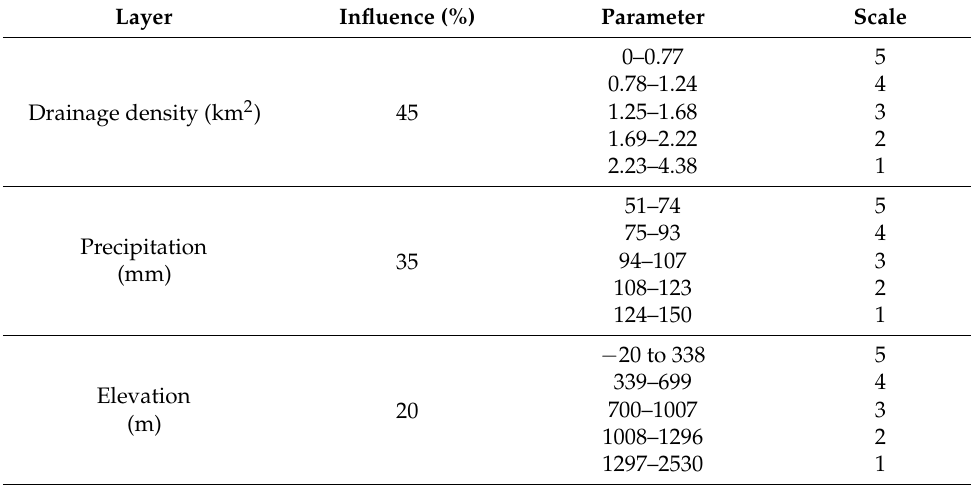
Figure 11. Map showing the areas in Neom with a very low, low, moderate, and high risk of flooding. Table 3 illustrates the significance of each of the five layers, whereas Figure 12 displays the results of the overlay analysis after assigning a priority and rating to each attribute. The likelihood of the occurrence of a drought in the Neom region was classified as very low, low, moderate, and high. The low-drought-risk area covered 4322 km 2 , whereas the areas with a very low, moderate, and high drought risk measured 43, 10,615, and 8266 km 2 , respectively. Table 3. Showing the layers used to predict the potential drought zones in Neom and the priority and rating of each